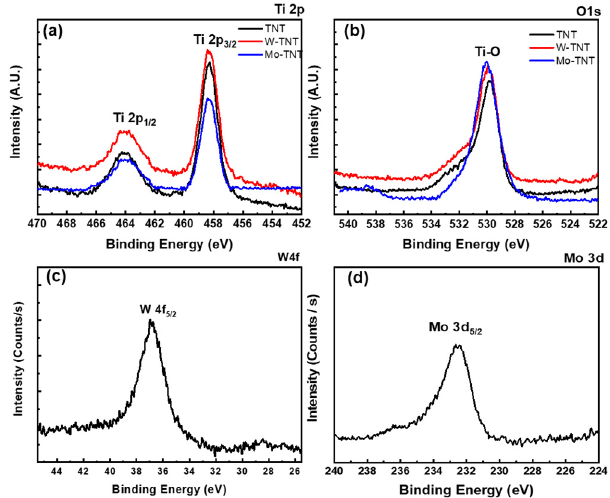
Figure 2. High-resolution XPS spectra of pure TNTs and synthesized Mo, W-doped titanate nanostructures, which confirms the presence of ( a )Ti 2p, ( b ) O 1s, ( c ) W 4f, ( d ) Mo 3d.